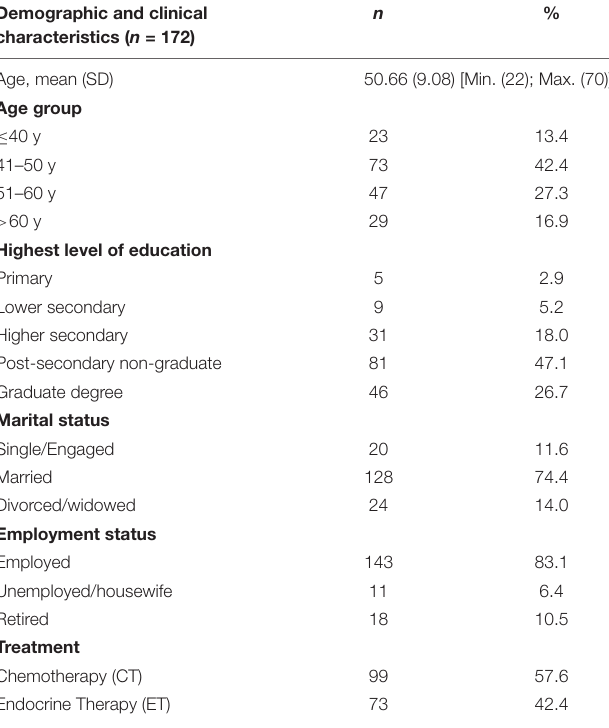
TABLE 1 | Sociodemographic and Clinical characteristics of the sample. Demographic and clinical characteristics ( n = 172)